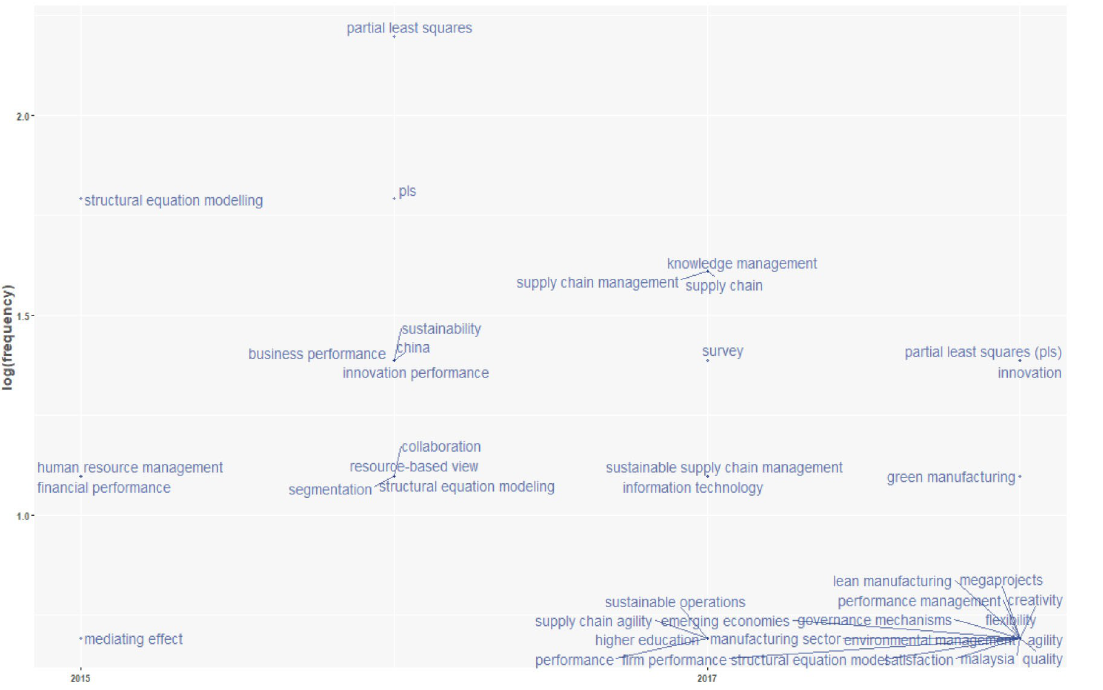
Figure 6. Trend Topics in the